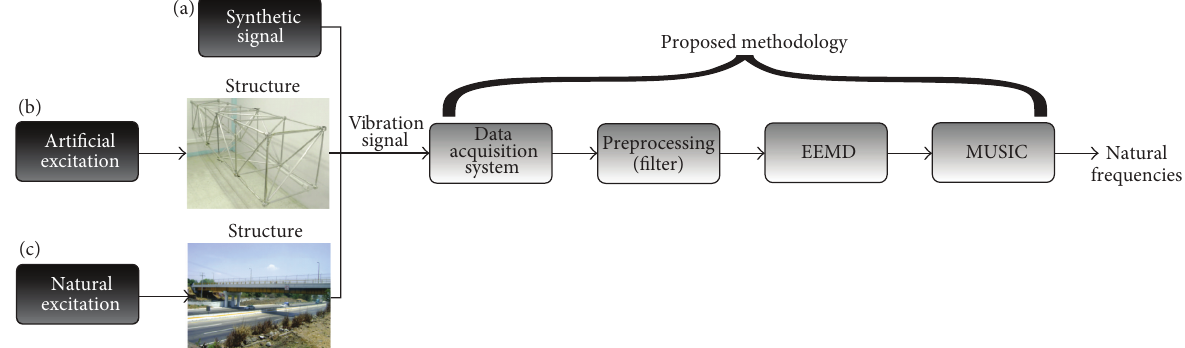
Figure 1: Proposed methodology. (a) Synthetic signal, (b) artificial excitation, and (c) natural excitation.